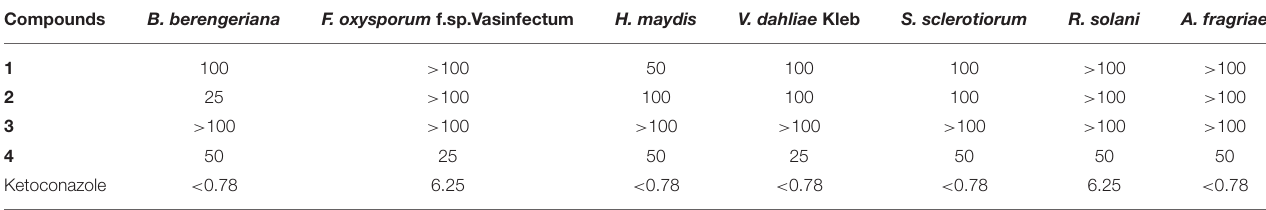
TABLE 1 | Antifungal activity of OA derivatives 1 – 4 (MIC, µ g/ml) a .